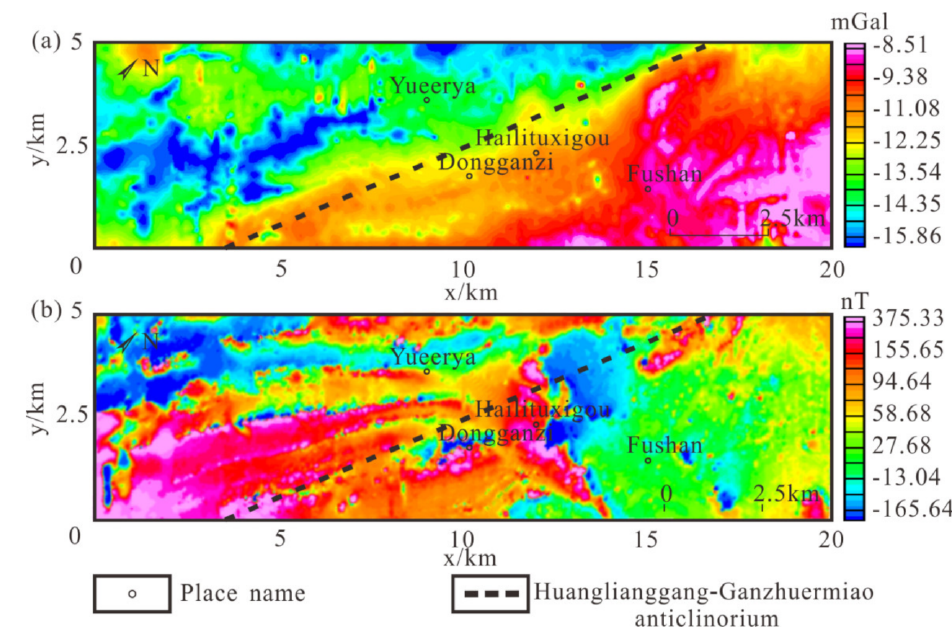
Figure 6. ( a ) Bouguer gravity anomaly in the Shuangjianzishan Baiyinnuoer area; ( b ) RTP magnetic anomaly in the Shuangjianzishan Baiyinnuoer